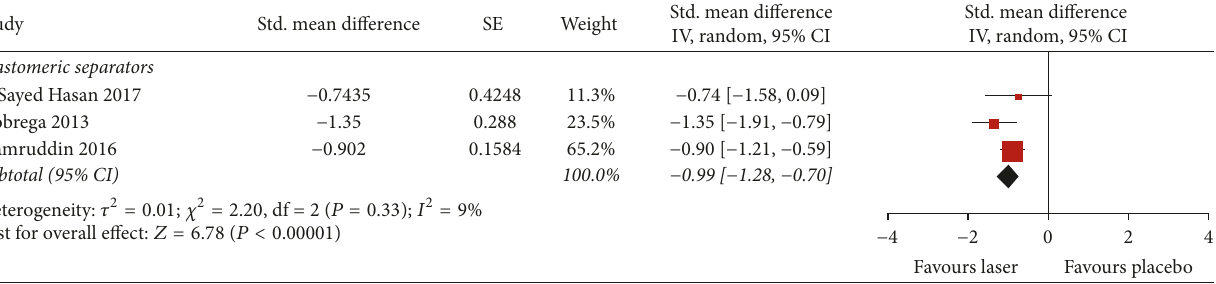
Figure 5: Forest plot of pooled standard mean difference in chewing pain at 24